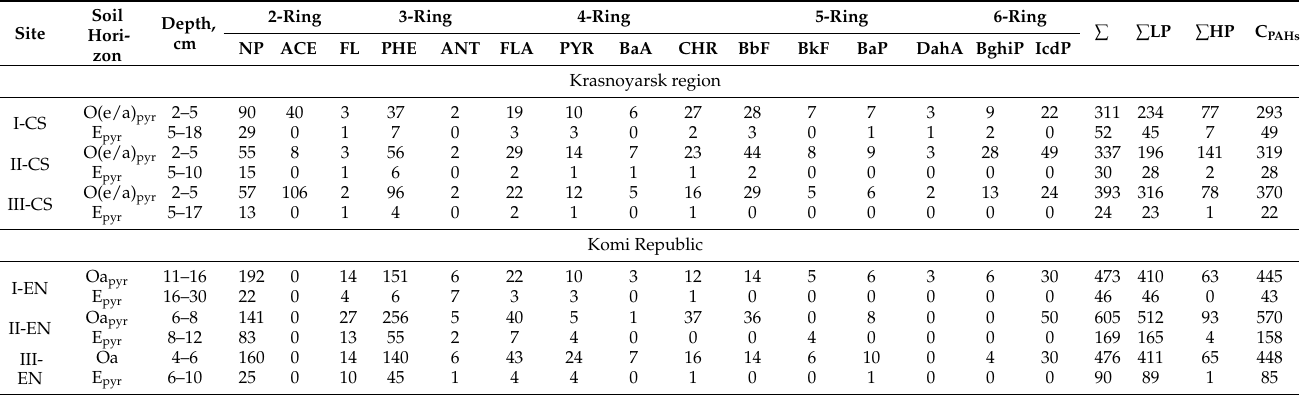
Table 5. PAH content in the upper horizons of the studied soils (ng g − 1